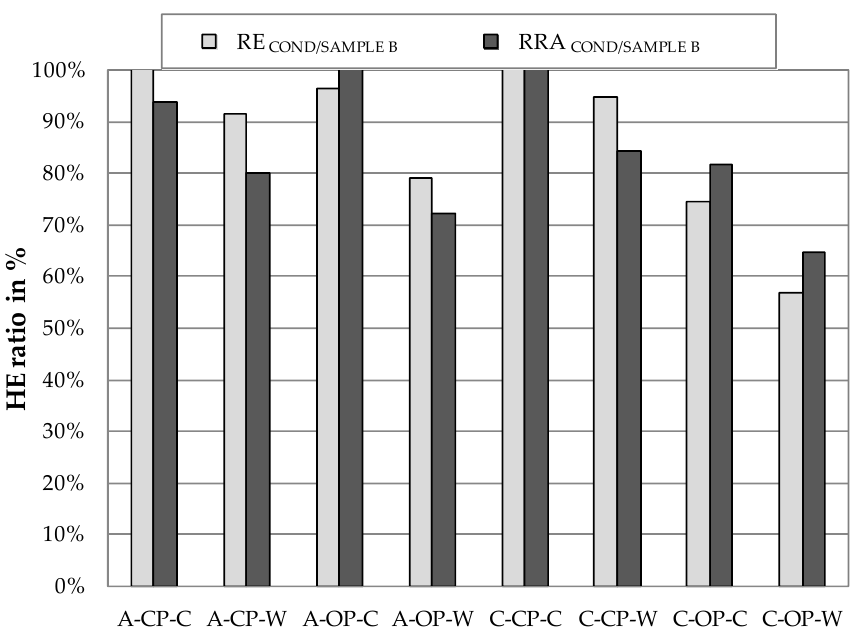
Figure 5. HE ratios with the average value obtained in each condition for material B as control reference.